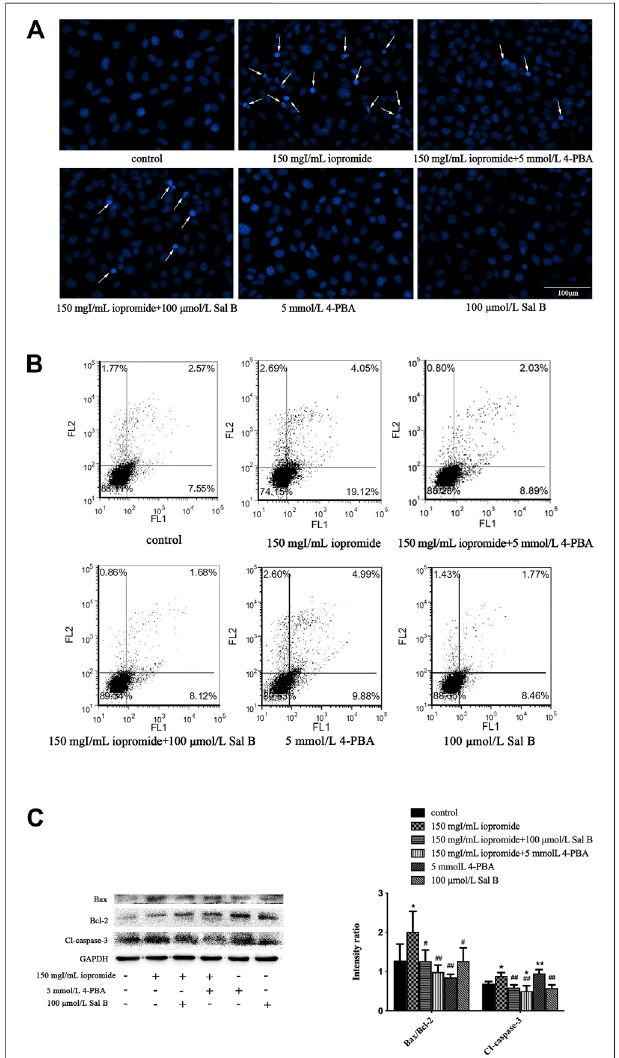
FIGURE5| SalBor4-PBAcounteractediopromide-inducedapoptosis. (A) SalBor4-PBAattenuatedtheiopromide-inducedapoptosisofHK-2cells. (B) Sal B or 4-PBA reduced the number of apoptotic cells. (C) Sal B or 4-PBA reduced the ratio of Bax/Bcl-2 and level of cleaved caspase-3. The data were determined by ANOVA and LSD post-hoc test and are presented as the mean ± SD ( n (cid:1) 3). * P < 0.05, ** P < 0.01 vs. control group; # P < 0.05, ## P < 0.01 vs. iopromide